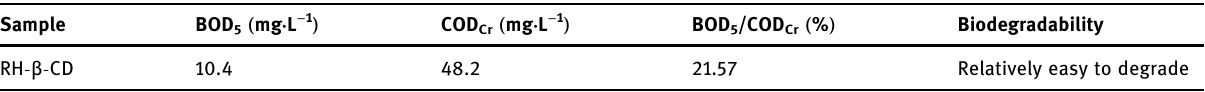
Table 2: Biodegradability test results of RH - β - CD